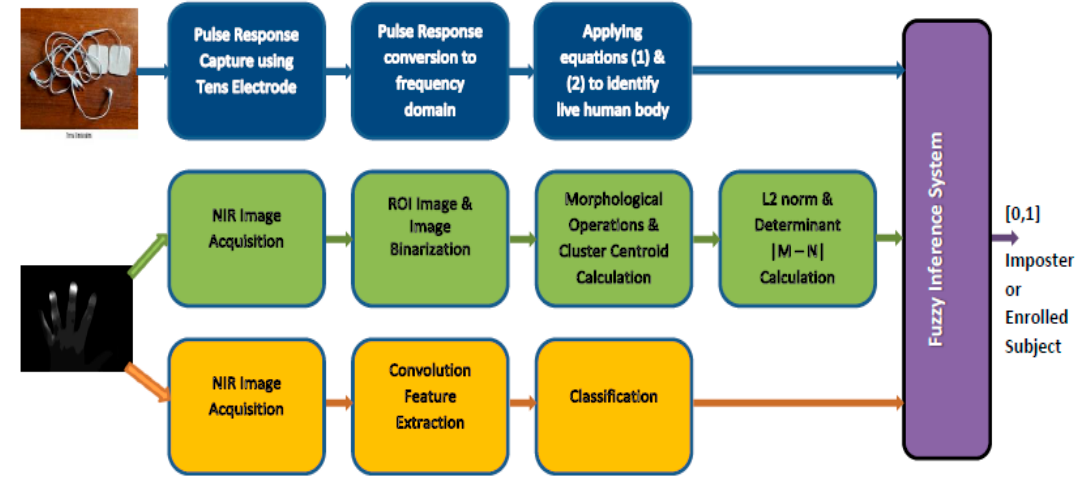
Figure 1. Block diagram of the proposed method. Blue = pulse response; green = hand geometry; and yellow = finger–vein.